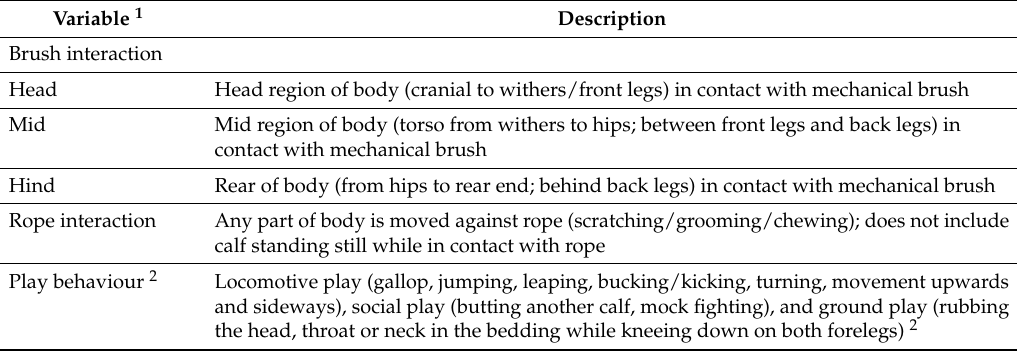
Table 1. Ethogram of calf interactions with the brush and rope, and play